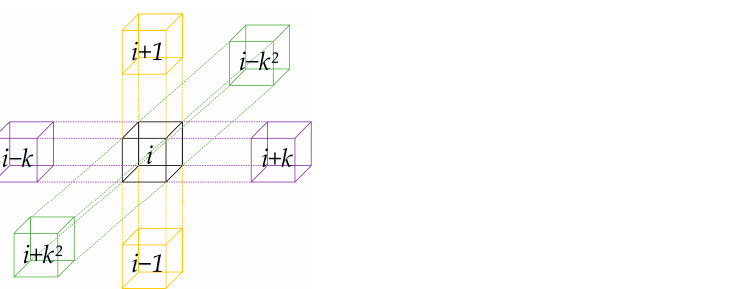
Figure 4. Schematic diagram of grid types.